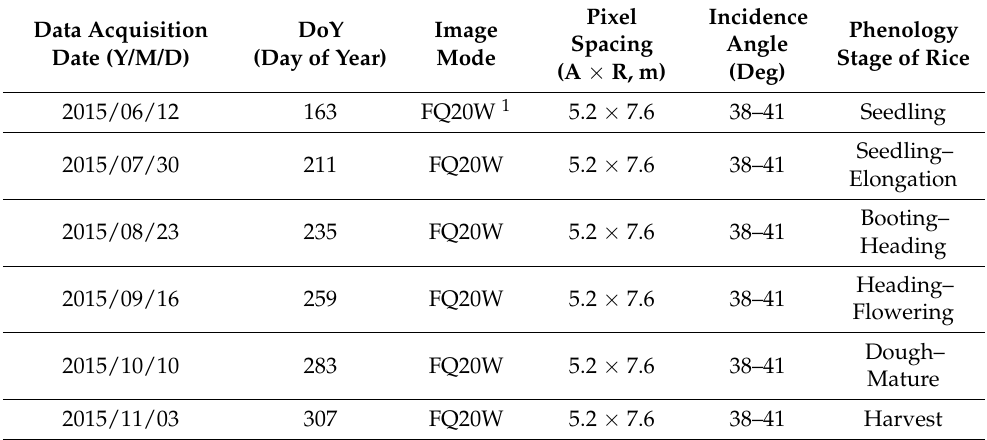
Table 1. Full polarization the SAR data parameters of the multi-temporal RADARSAT-2.